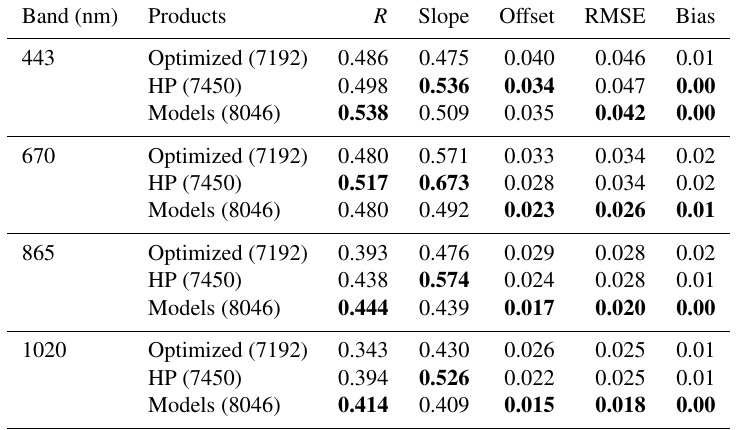
Table 8. Global statistics of PARASOL/GRASP spectral AAOD vs. AERONET AAOD. The best performing at each wavelength of three approaches by each metric is labeled in